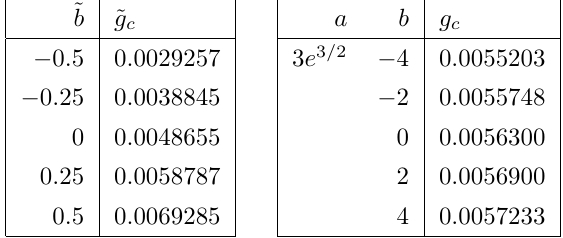
Table 1 . Values of the triple points for the phase diagrams in the (cid:12)gure